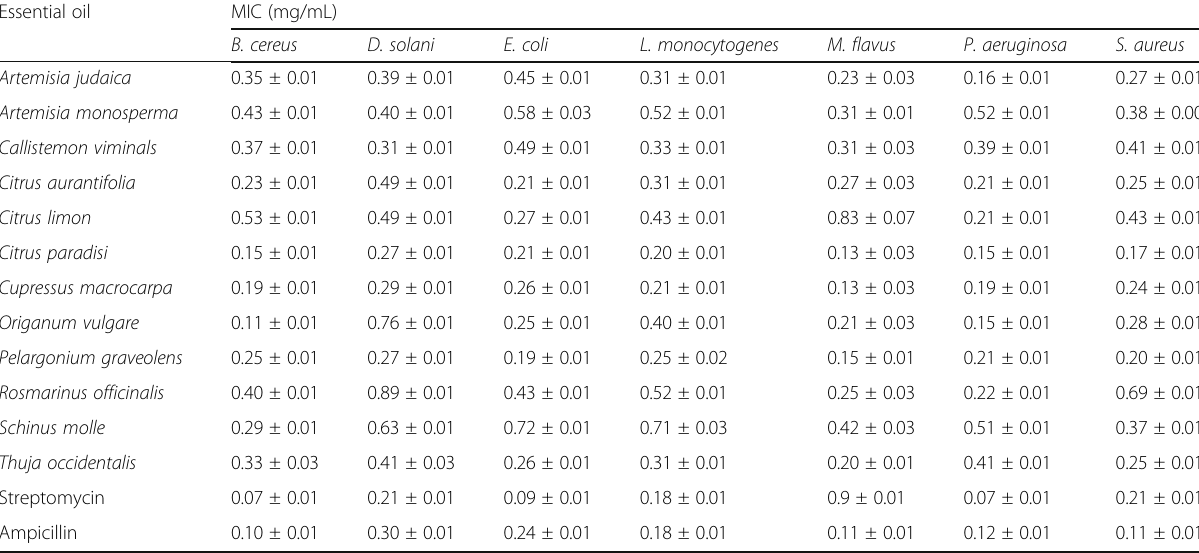
Table 5 Minimum inhibitory concentrations (MIC) of essential oils on bacterial strains Essential